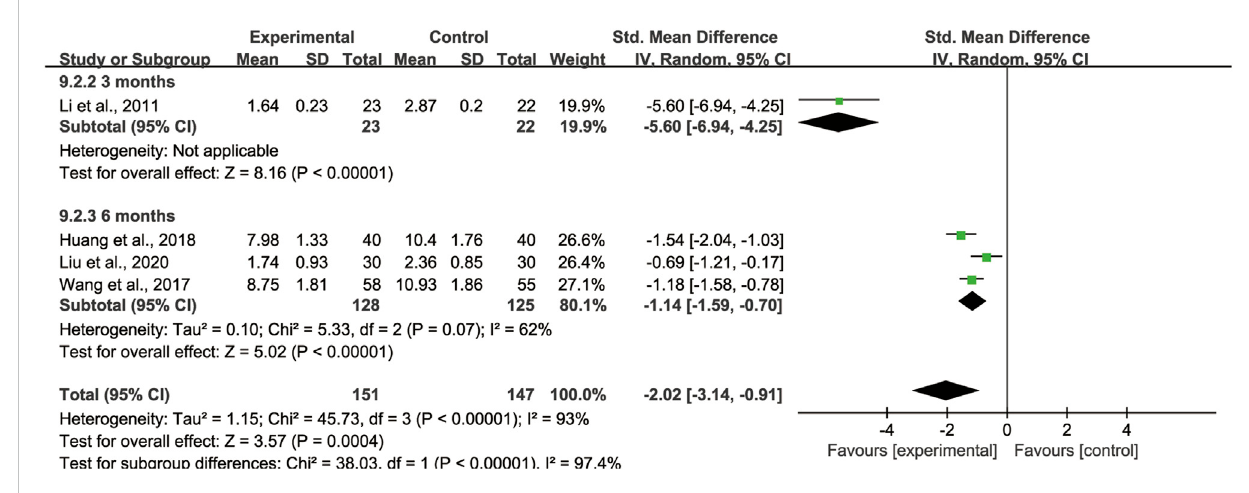
FIGURE 11 Subgroup analysis of HRCT integral of lungs based on different treatment duration.